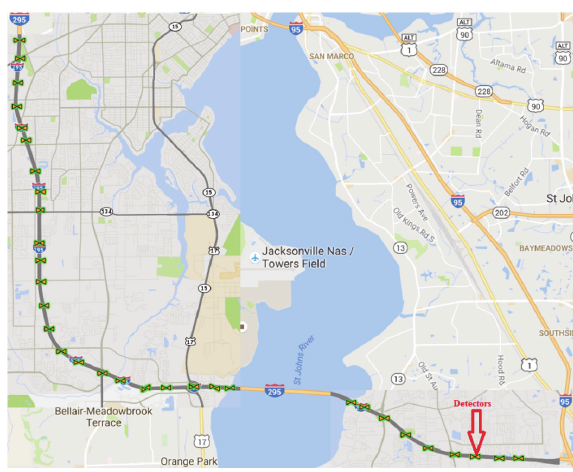
Figure 2: The study